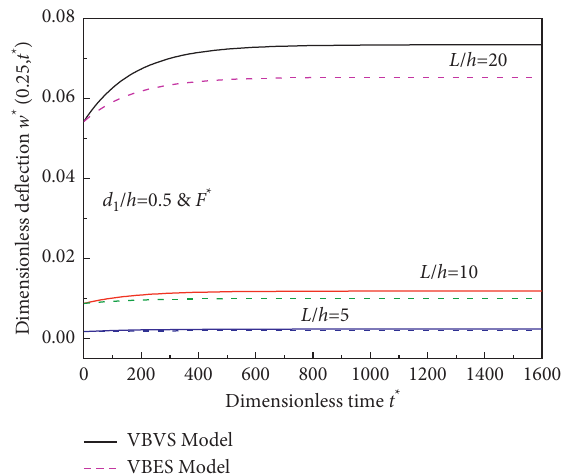
Figure 13: Response of dimensionless deflection w ∗ (0.25, t ∗ ) versus dimensionless time t ∗ of the continuous cracked beams with different slenderness ratio L / h .